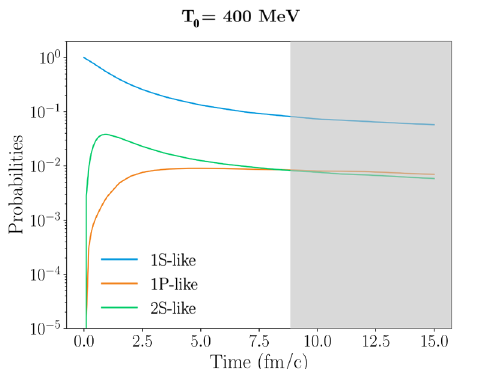
Figure 3. Evolution over time of the vacuum eigenstates populations from an initial temperature T 0 = 400 MeV. The grey band indicates the range in time where T ( t ) < 200